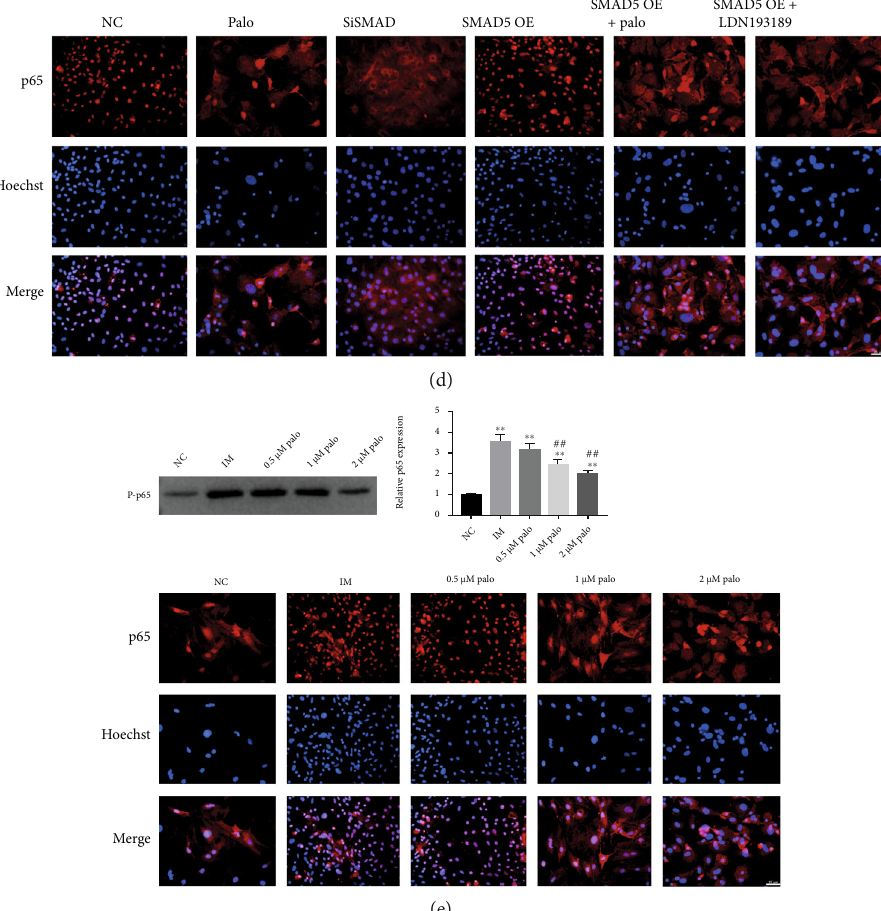
Figure 4: Smad and NF- κ B signaling pathways play a synergistic role in HO formation, and palovarotene inhibits HO formation by blocking the Smad and NF- κ B signaling pathways. (a) The mRNA expression of OCN, SOX9, RUNX2, Smad1, Smad5, and ID1. Data are means ± SD ( n = 3 ). ∗ p < 0 : 05 and ∗∗ p < 0 : 01 . # p < 0 : 05 and ## p < 0 : 01 . (b) Immuno fl uorescence against ID1 ( n = 3 ). Scale bar = 25